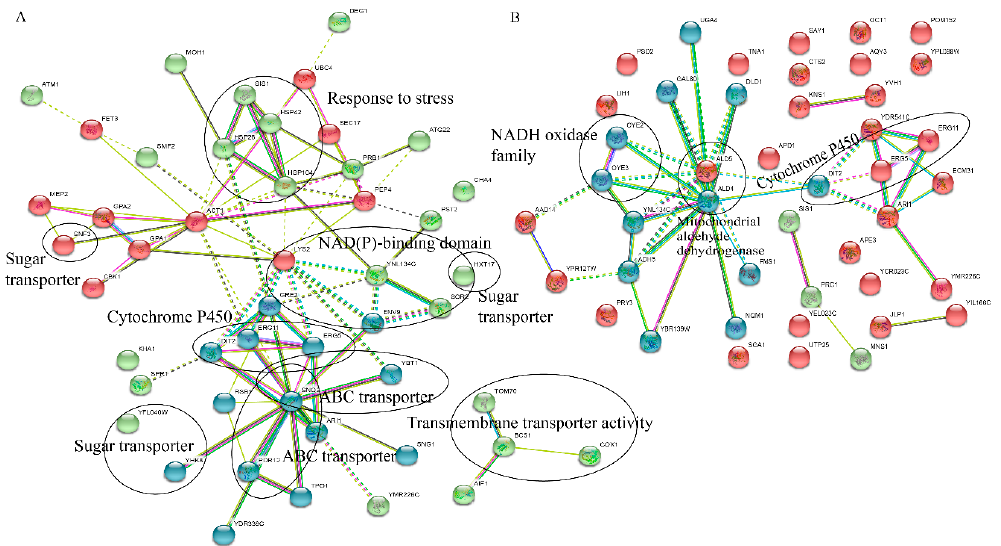
Figure 4. STRING analysis. A protein interactive network was used to display the genes that were related to the highly up-regulated, differently expressed unigenes ( A ), or related to the highly down-regulated, differently expressed unigenes ( B ). Gene products are represented with circles and known associations between each gene or gene product are represented with a connecting line. Nodes of genes participating in similar functions are circled in red or in blue or in green. The network cluster was based on the k-means clustering method.